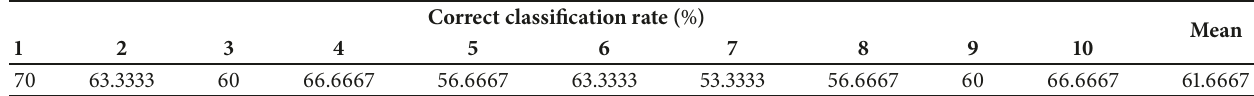
Table 9: The classification results using